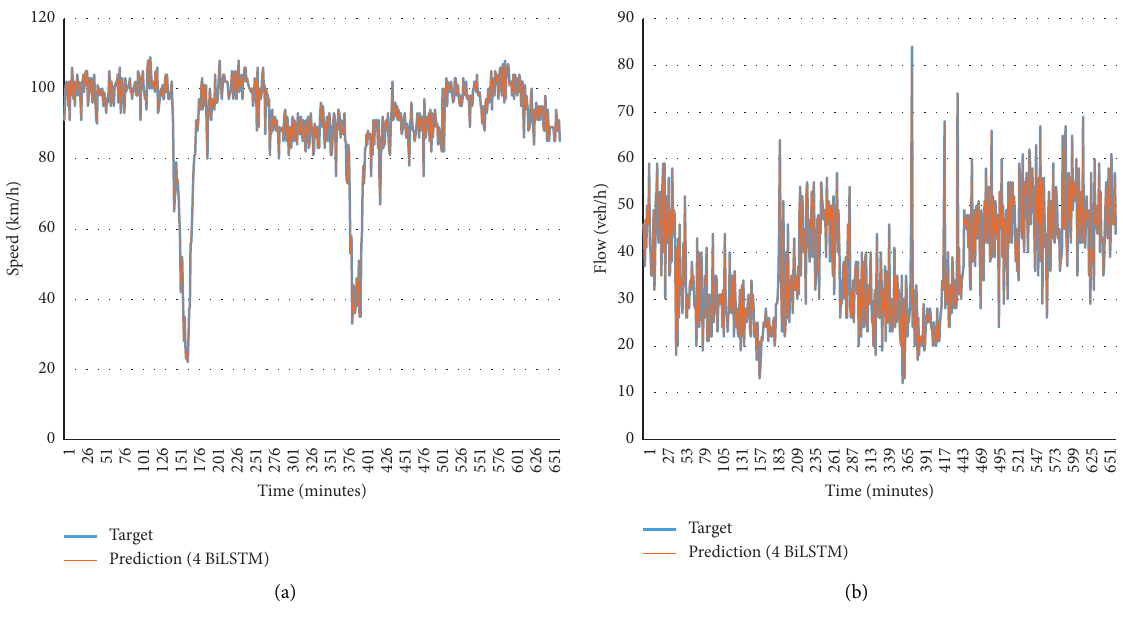
Figure 9: Pacific Motorway speed and flow prediction results for 15-minute horizons using the 4-BiLSTM